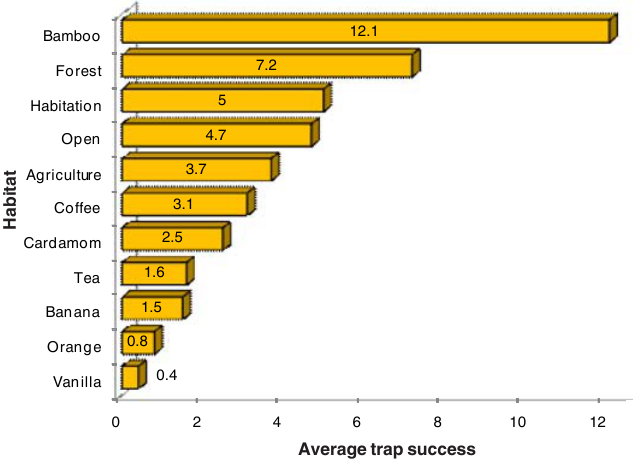
Table 6. Diversity indices of non-volant small mammals in 12 habitats in Coorg